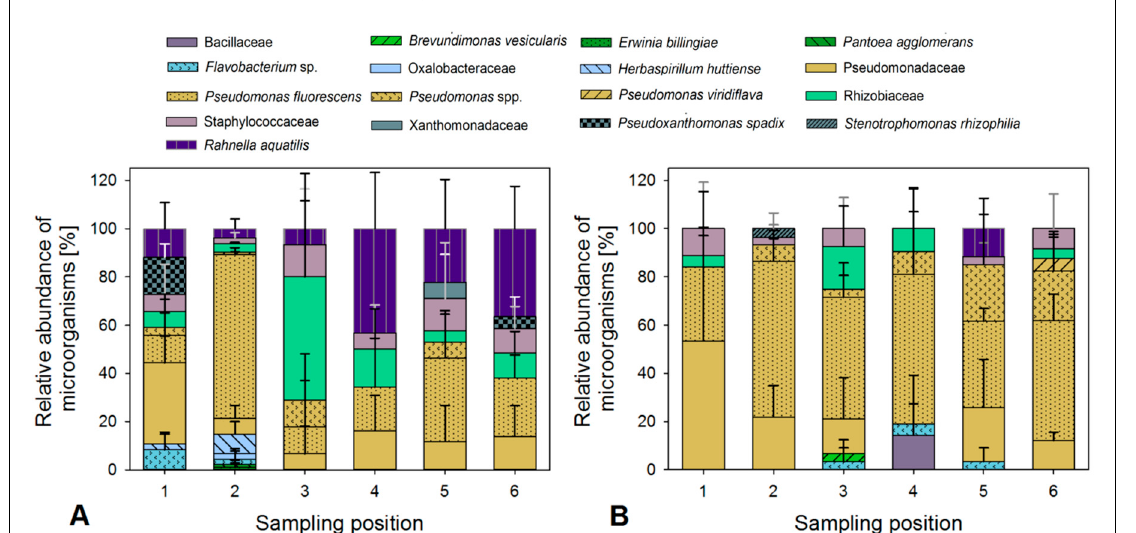
Figure 1. Culturable microbial community structure of endive lettuce (identified colonies only) along the washing process chain. The washing was conducted without the addition of sanitizers (trial A) and the samples were analyzed after washing ( A ) and after storage for seven days at 2 °C ( B ). Sampling positions: (1) endive raw material; (2) endive after pre-bath; (3) endive after pre-rinsing; (4) endive after first wash; (5) endive after second wash; (6) endive after final rinsing.